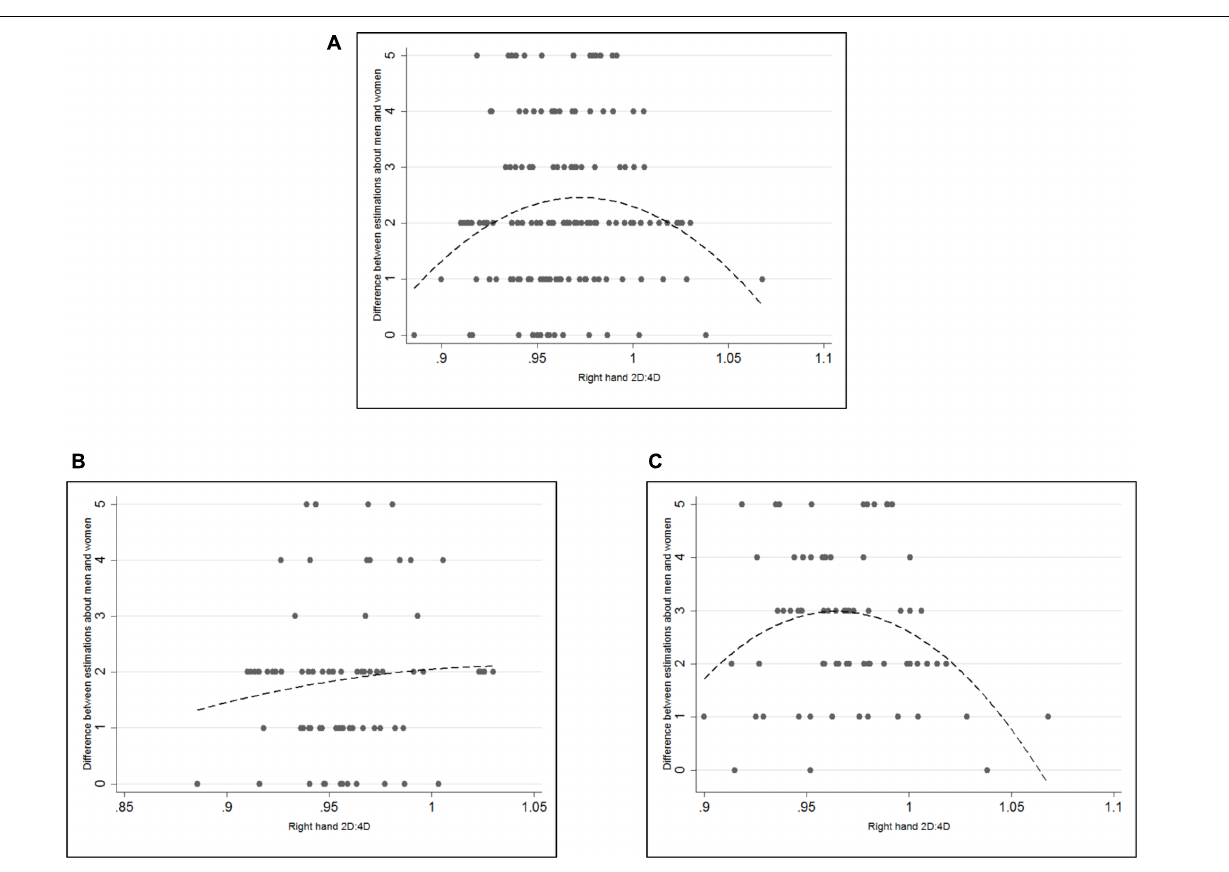
Frontiers in Behavioral Neuroscience |